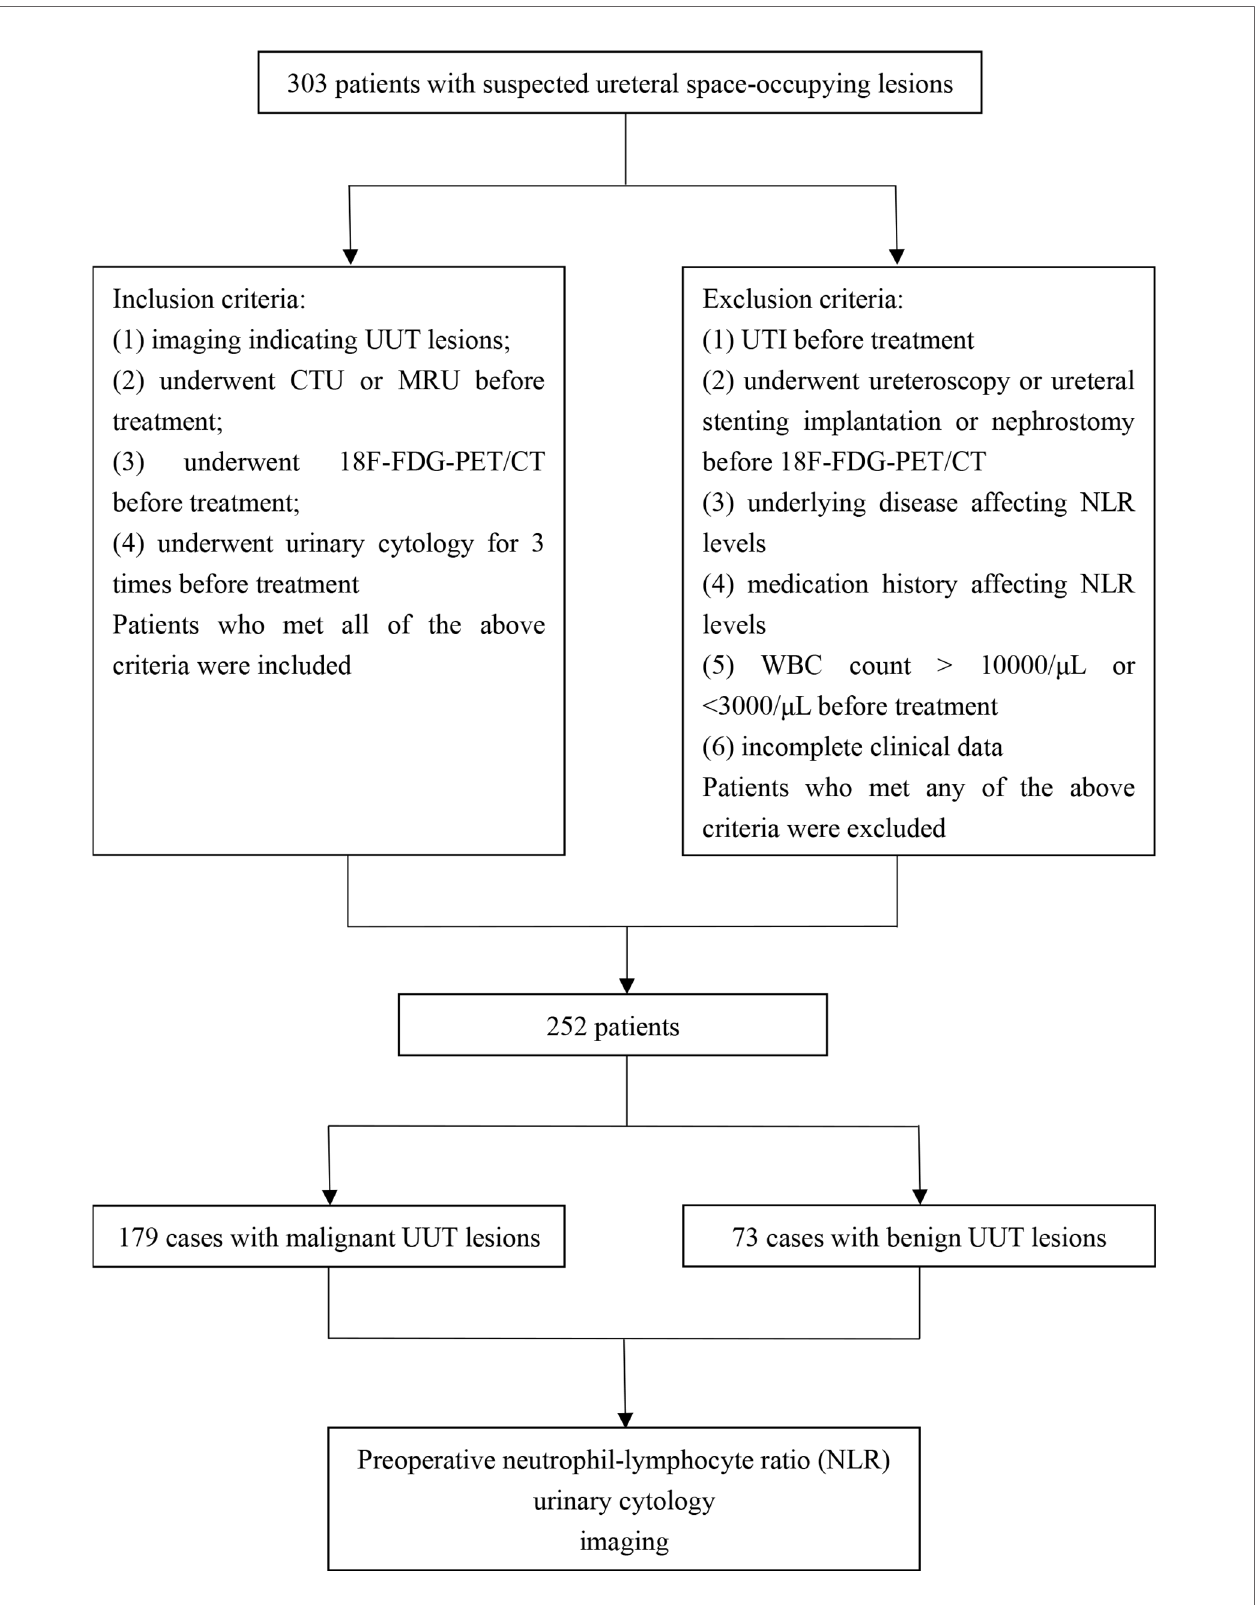
FIGURE 1 | The fl ow chart of this